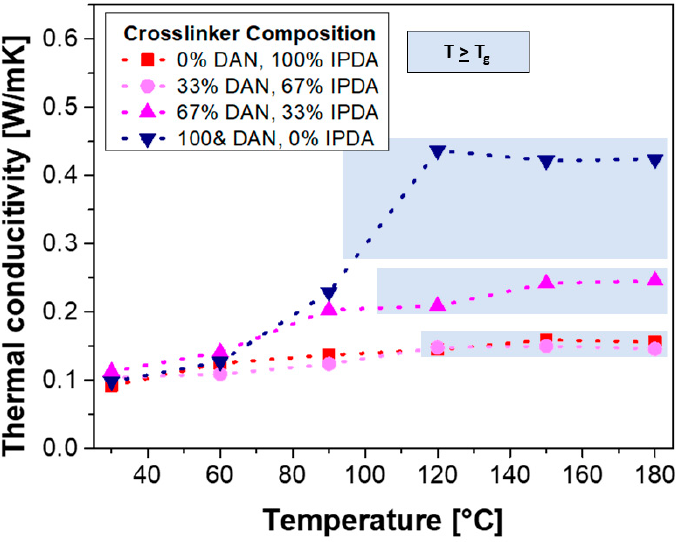
Figure 5. Thermal conductivity of unfilled BADGE/DEO-based epoxy-amine resins ( a,c ) and the corresponding nanocom- posites with SiO 2 fillers ( b,d ). For comparison, the Z-scales of all graphs have been drawn to the same height.